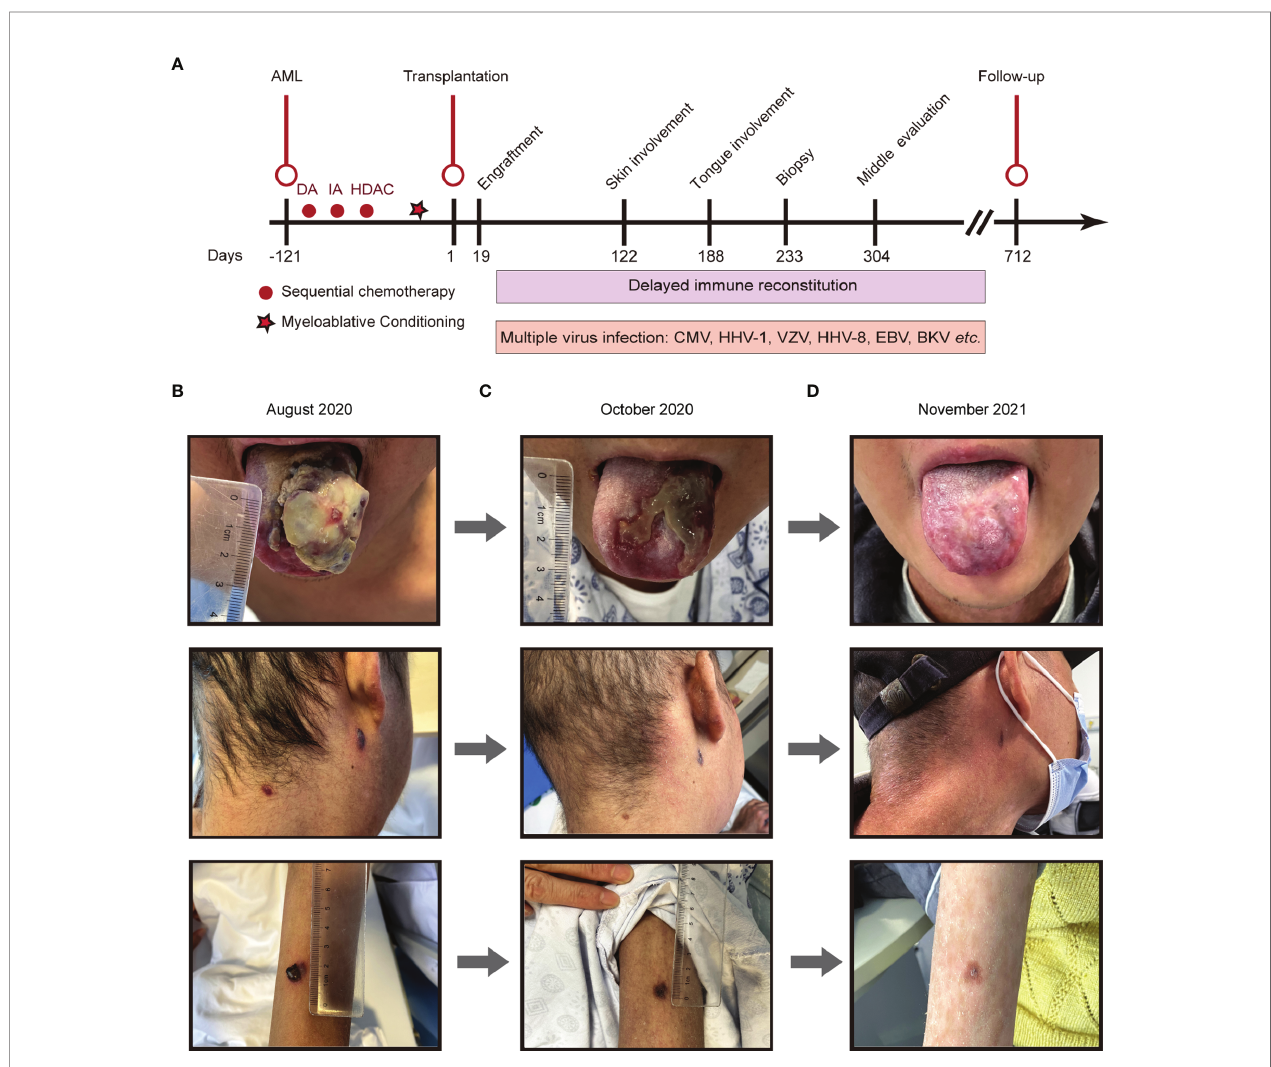
FIGURE 1 | The disease development of the patient from different periods. (A) , Main timeline of patient disease development. (B-D) , Different periods of Kaposi sarcoma on the tongue, cervical skin, and skin of the right forearm. (B) , August 13th, 2020; (C) , October 14th, 2020; (D) , November 26th, 2021. DA, daunorubicin hydrochloride and cytarabine; IA, idarubicin hydrochloride and cytarabine; HDAC, high dose